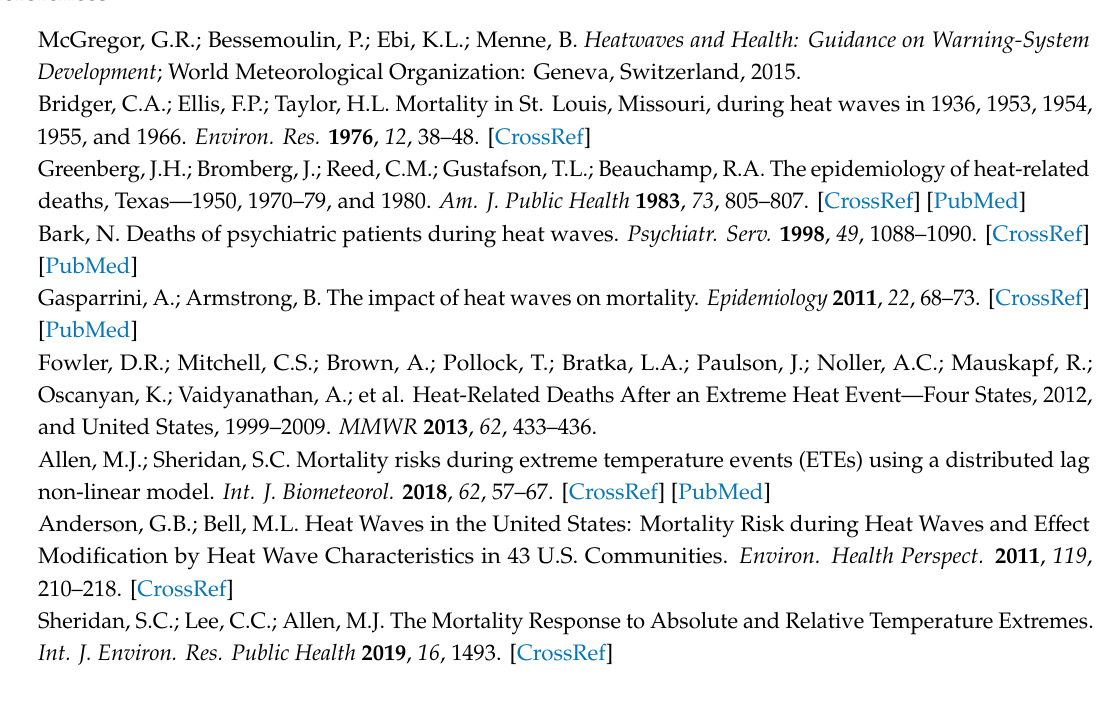
Figure S1: Mortality rate and median household income by census tract in Shelby County, TN; Table S1: E ff ects of heatwave days on all-cause mortality on heatwave (HW) days and 1, 2, and 3 lag days; Table S2: E ff ects of heatwave days on cardiovascular disease mortality on heatwave (HW) days and 1, 2, and 3 lag days; Table S3: E ff ects of heatwave days on respiratory disease mortality on heatwave (HW) days and 1, 2, and 3 lag days. Author Contributions: Conceptualization, C.J. and Y.L.; methodology, Y.L. and X.Y.; formal analysis, X.Y.